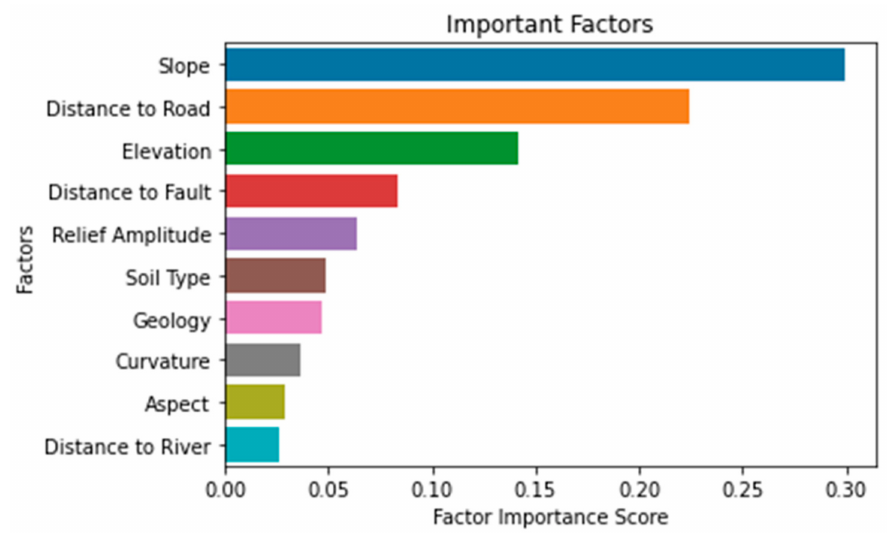
Figure 5. The role of the influencing factors.